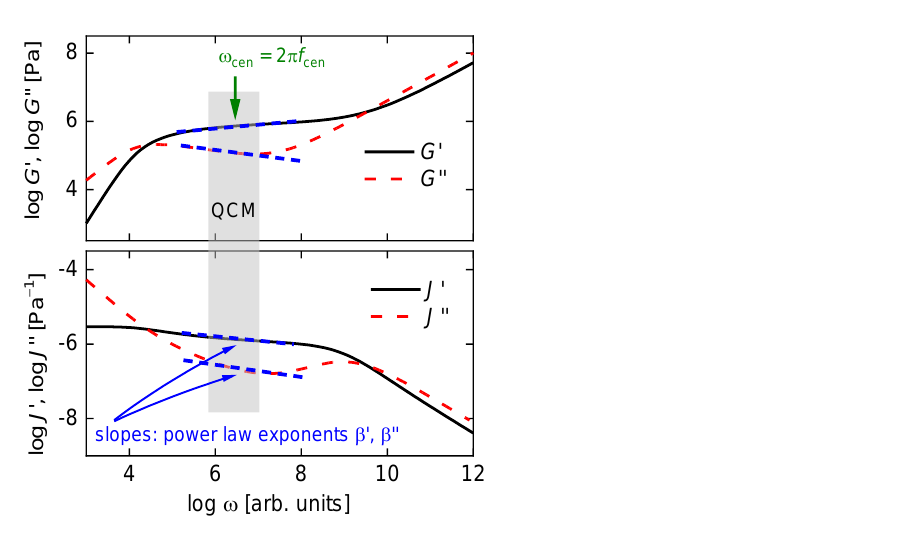
Figure 24. The shear modulus of viscoelastic media depends on frequency. The plot shows a typical rheological spectrum of a solution of a long-chain linear polymer. The frequency scale extends over many decades, while the QCM only covers about one decade. In this limited frequency range, G (cid:48) ( ω ) and G (cid:48)(cid:48) ( ω ) can be approximated by power laws (dashed blue lines). The chosen example displays what is called the rubber plateau. Would the frequency scale extend further to the right, there would be a second maximum in G ’’( ω ), caused by segmental relaxations and the glass transition.